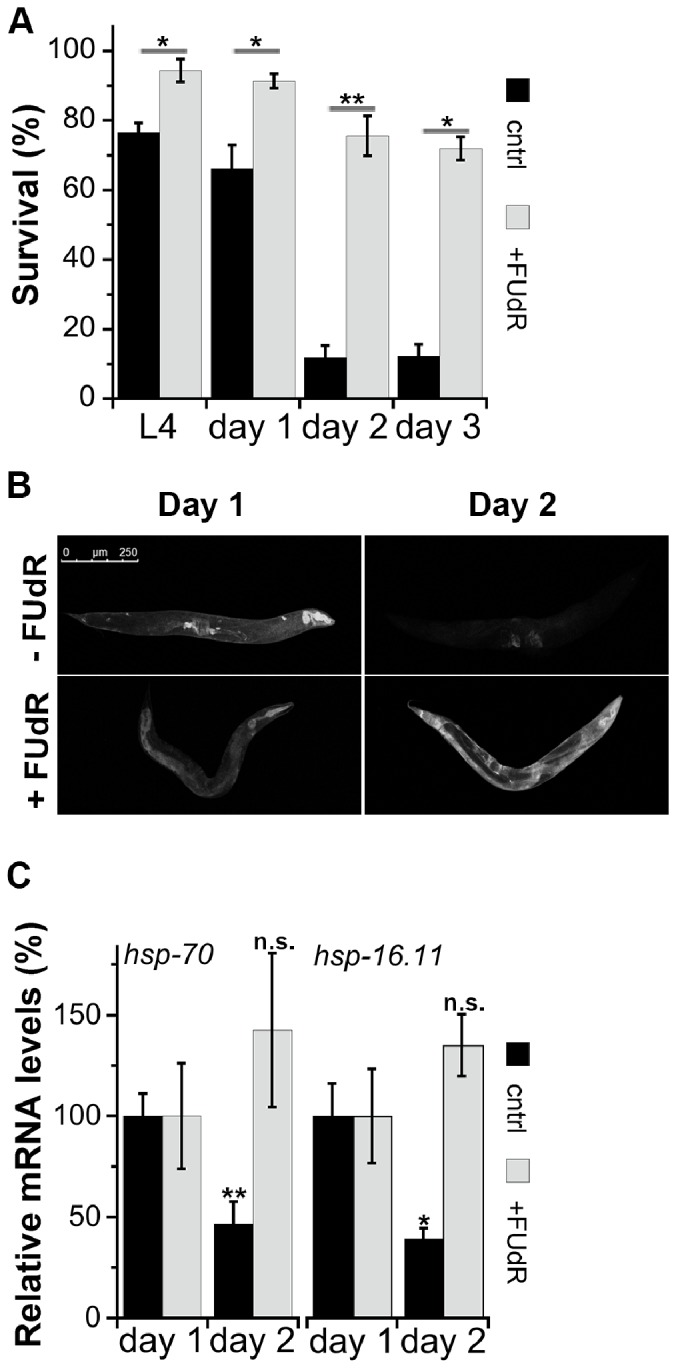
Animals raised on FUdR maintain the ability to mount a protective stress response during adulthood.(A) Age-synchronized wild type (wt) animals raised in the absence (black) or presence (gray) of FUdR were exposed to a 37°C HS for 6 h and survival was assayed. Data represent means ± SEM of >4 independent experiments. P values compare age-matched treated and untreated animals. (*) P<0.05 and (**) P<0.01. (B) Images of age-synchronized wild type animals expressing GFP under control of the hsp-16.2 promoter (phsp-16.2::GFP) raised in the absence or presence of FUdR and subjected to a short HS (90 min at 37°C) on the first or second day of adulthood. Scale bar is 250 µm. (C) Quantification of hsp-70 (left) and hsp-16.11 (right) mRNA levels from age-synchronized wild type animals raised in the absence (black) or presence (gray) of FUdR and challenged with a short HS (90 min at 37°C) on the first or second day of adulthood. The data presented are normalized to day 1 of adulthood HS treated animals. Data represent means ± SEM of >3 independent biological samples. P values compare mRNA levels on the second day of adulthood with same-treated animals on day 1 of adulthood. (*) P<0.05 and (**) P<0.01.